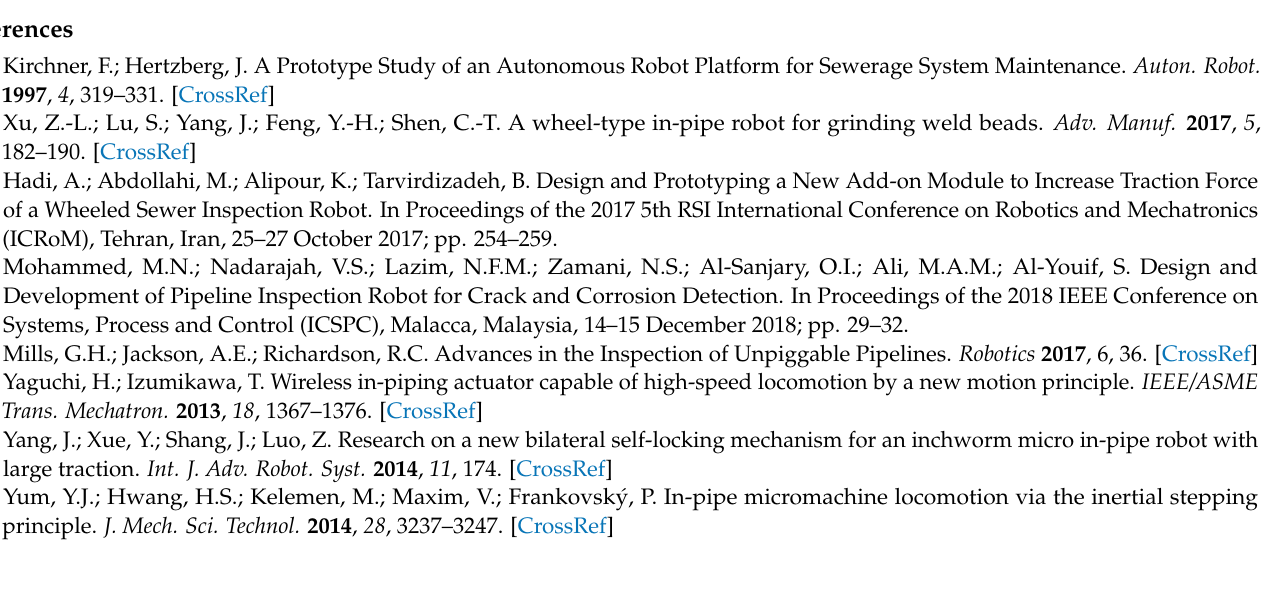
Figure 15. The internal surface of the pipe captured by the front camera: ( a ) a rusty surface; ( b ) slag ash.